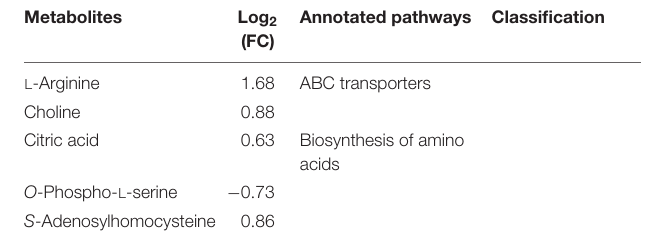
TABLE 2 | Significantly changed DMs in distal intestine of hybrid